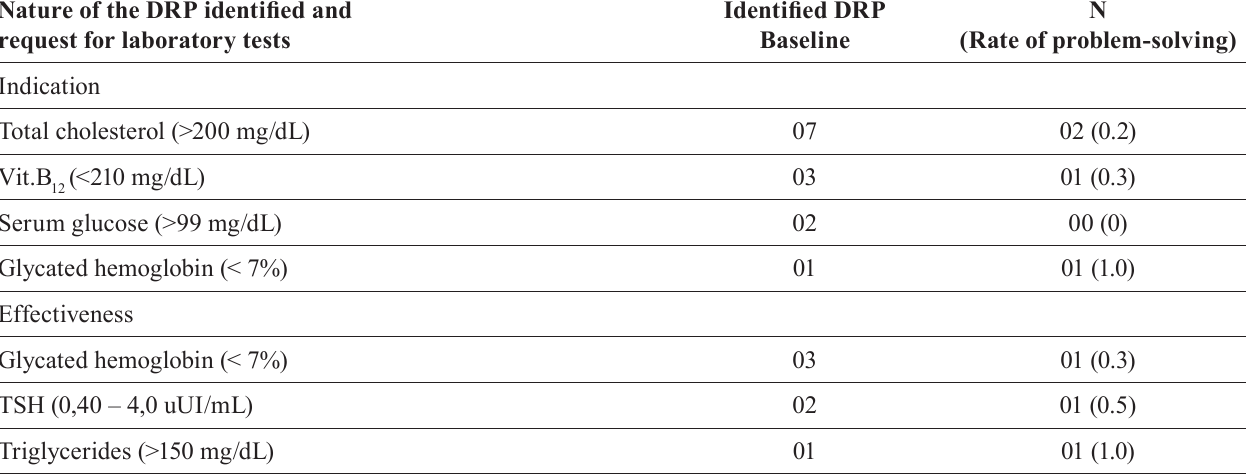
TABLE IV - Request for laboratory tests to identify and monitor the Drug Related Problem (DRP) identified and the respective rate of problem-solving indices by the Medication Therapy Management, Araraquara Nature of the DRP identified